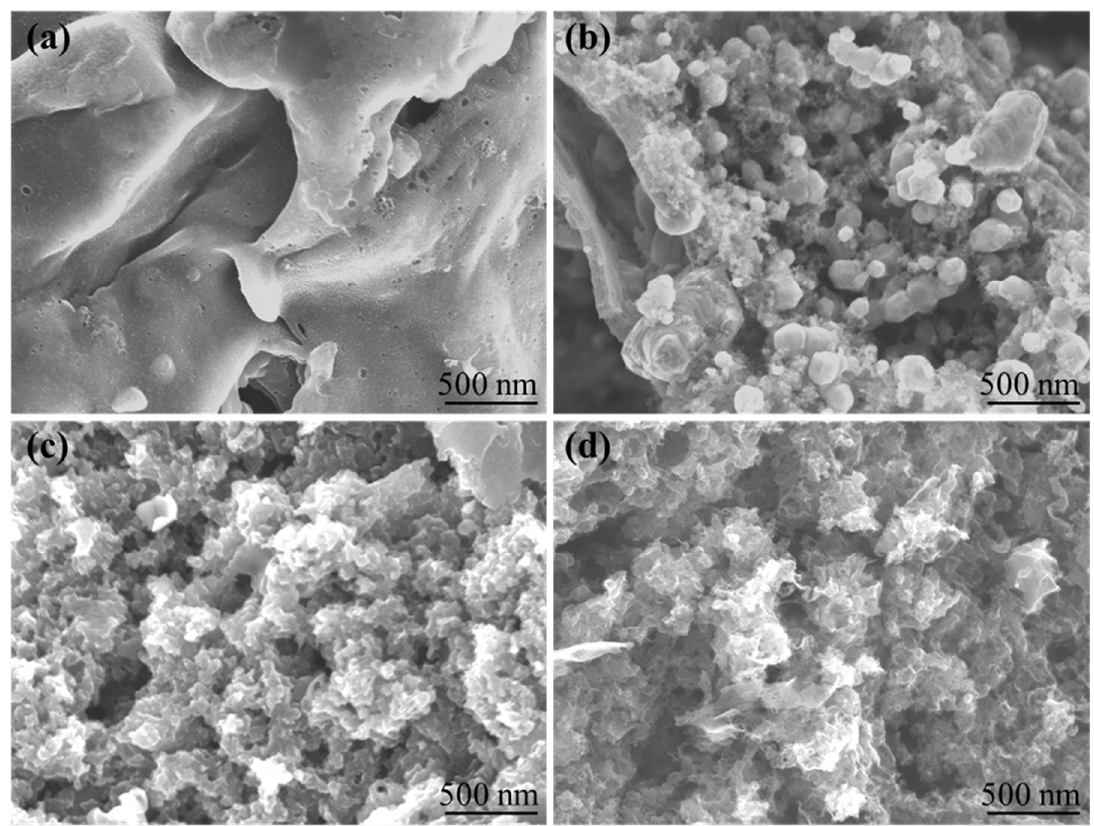
Figure 3. SEM images of ( a ) RBC, ( b ) CBC before removal of metal particles, ( c ) CBC after removal of metal particles, and ( d ) CBC-50-TEPA.